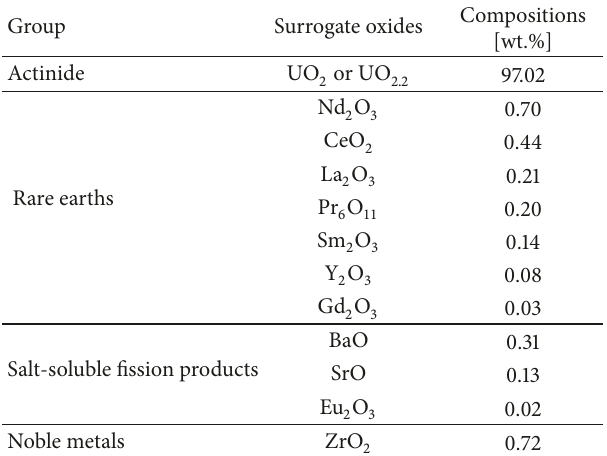
Salt-soluble fission products